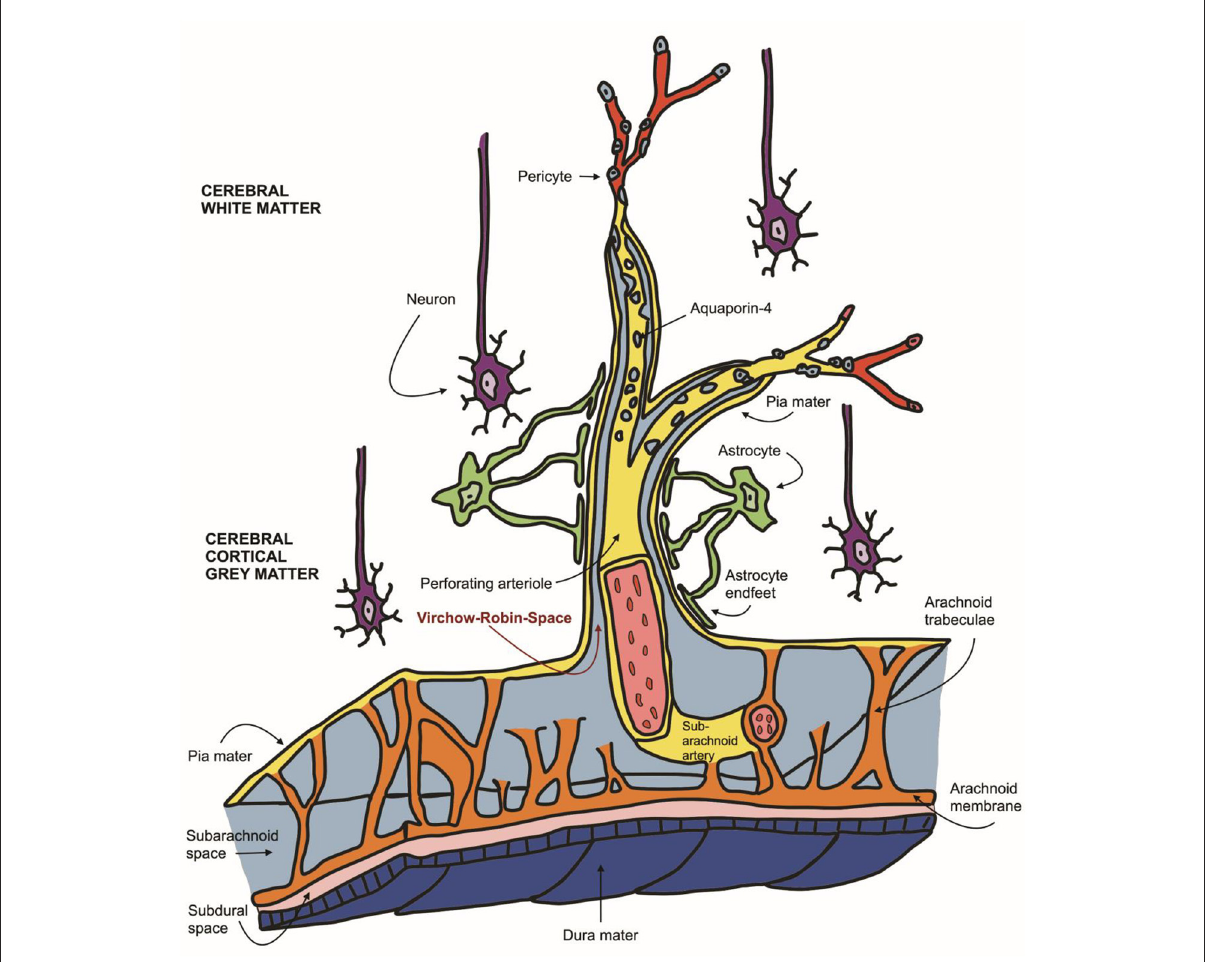
FIGURE1 Schematic representation of the neurovascular unit: Virchow-Robin spaces encompassing perforating arteries are filled with CSF as they communicate directly with the subarachnoid space (light blue). VRS (red arrow) are enveloped in two leptomeningeal membranes (yellow), the inner leptomeningeal cell layer facing the arterial wall and the outer membrane, contiguous with the pia mater, facing perivascular astrocytic endfeet